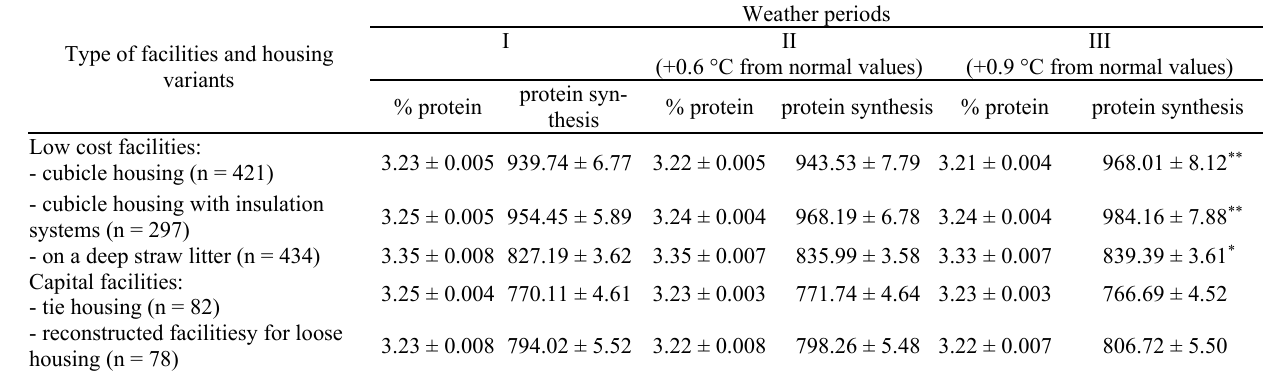
The average mass fraction of protein in cow's milk (%) and its synthesis during research period, kg/head